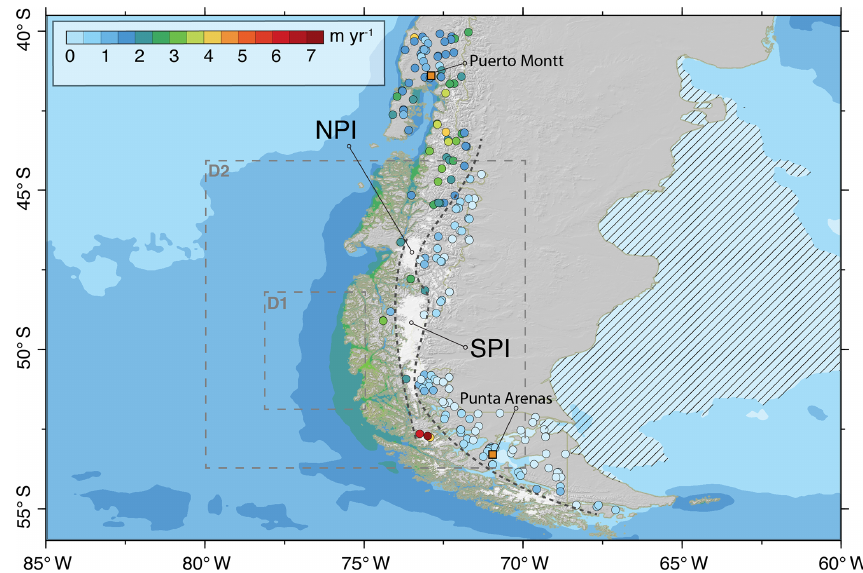
Figure 1. Precipitation climatology in southern South America. The filled-in circles indicate precipitation amounts observed by the observa- tional network of the Dirección Meteorológica de Chile (DMC) and the Dirección General de Aguas (DGA). Also included are the permanent weather station measurements that were taken at the Gran Campo Nevado Ice Cap. The colour-shaded areas over the ocean show the rainfall distribution based on the Global Precipitation Measurement (GPM) satellite mission. Black dashed lines roughly delineate the maritime Pre- cordillera range, Andes main ridge and the semiarid Pampa region. Also indicated are the Northern (NPI) and Southern Patagonian Icefields (SPI). The dashed area shows the semi-arid rain-shadow region. Also shown are the simulation (D2) and forcing (D1)